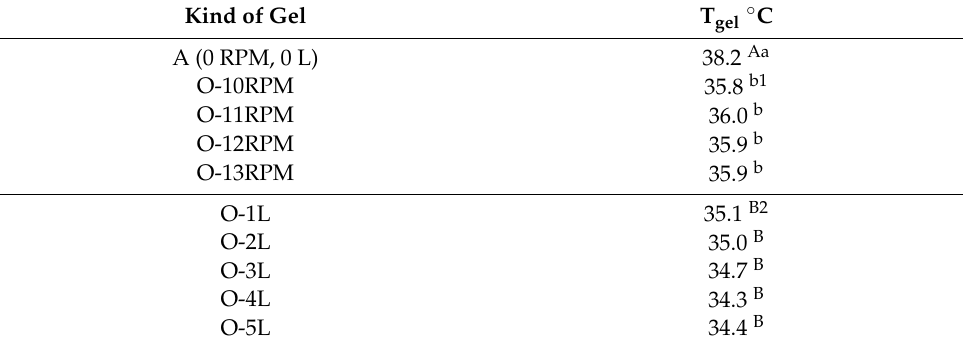
Table 1. Gelation temperature (T gel ) of different agar